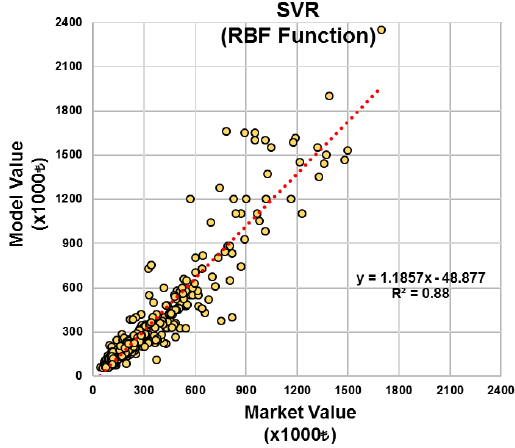
Figure 4 . Comparison of SVR model with market values